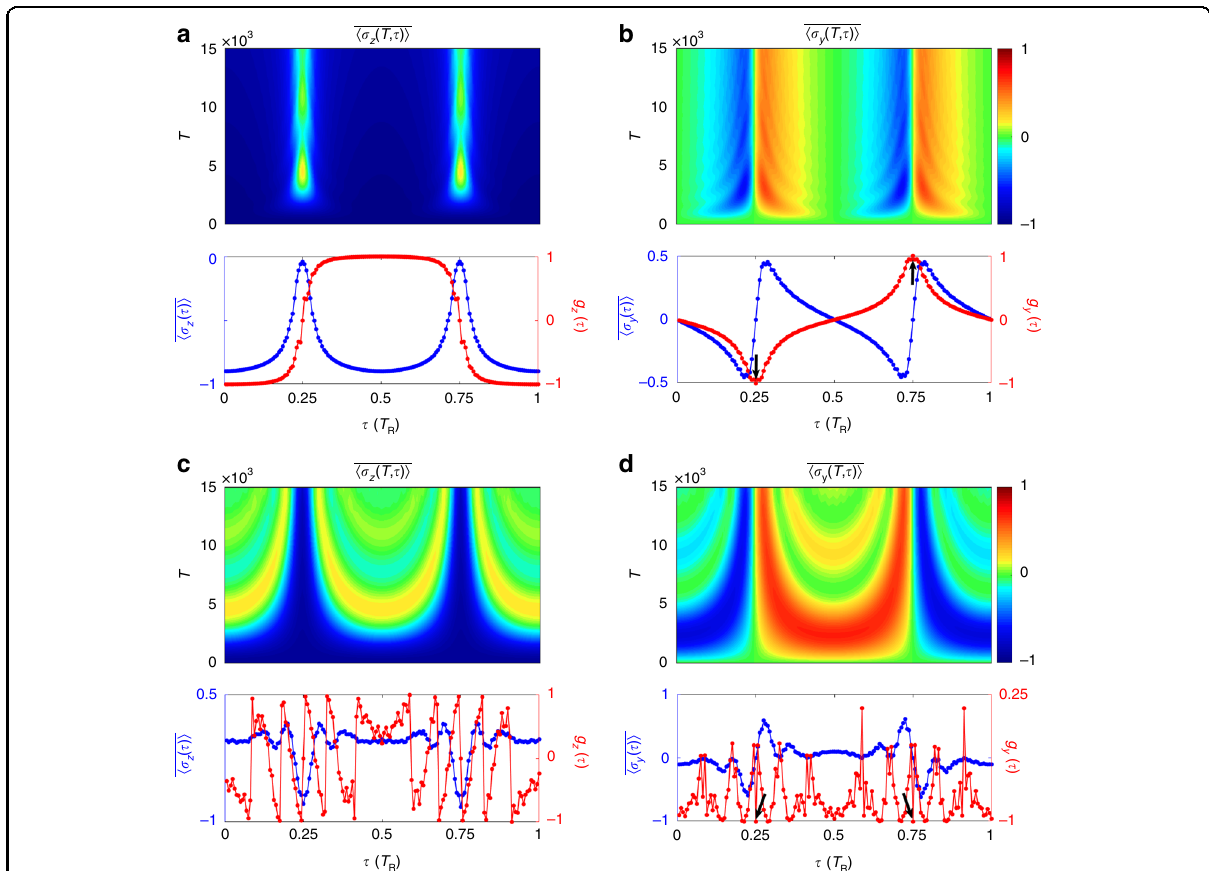
Fig. 3 The time evolution of the normalized spin textures reconstructed by using two time scales ( τ and T ). a , b The evolution of averaged spin polarization h σ z ; y ð T ; τ Þi , the overall spin polarization h σ z ; y ð τ Þi , the dynamical spin texture g z ; y ð τ Þ , respectively, with ϕ ¼ π . c , d The evolution of averaged spin polarization h σ z ; y ð T ; τ Þi , the overall spin polarization h σ z ; y ð τ Þi , the dynamical spin texture g z ; y ð τ Þ , respectively, with ϕ ¼ 0. Black arrows point to values of g y ð τ 1 ; 2